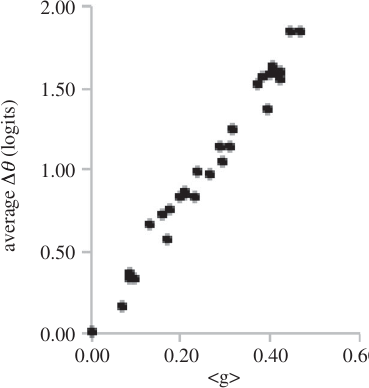
FIG. 12. The pre- and postability histogram for class 29. FIG. 10. Average